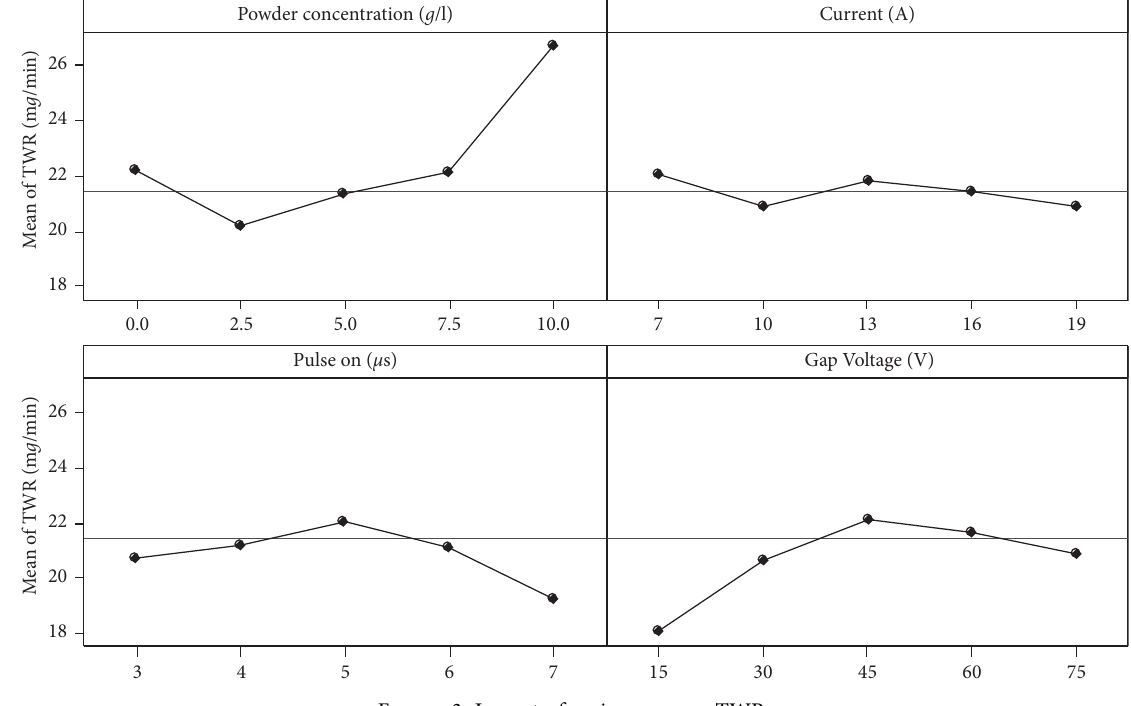
Figure 3: Impact of various p-p on